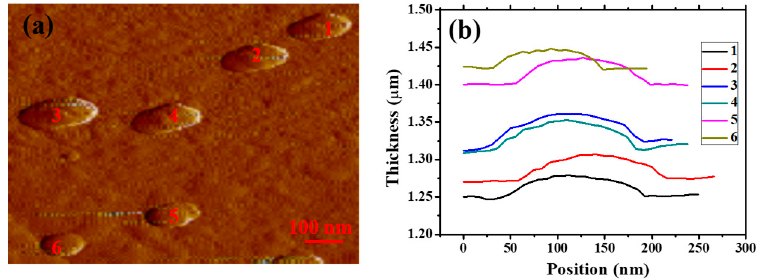
Figure 3. ( a ) The AFM image of the Cr 2 Ge 2 Te 6 nanosheets; ( b ) the corresponding thicknesses of different samples.